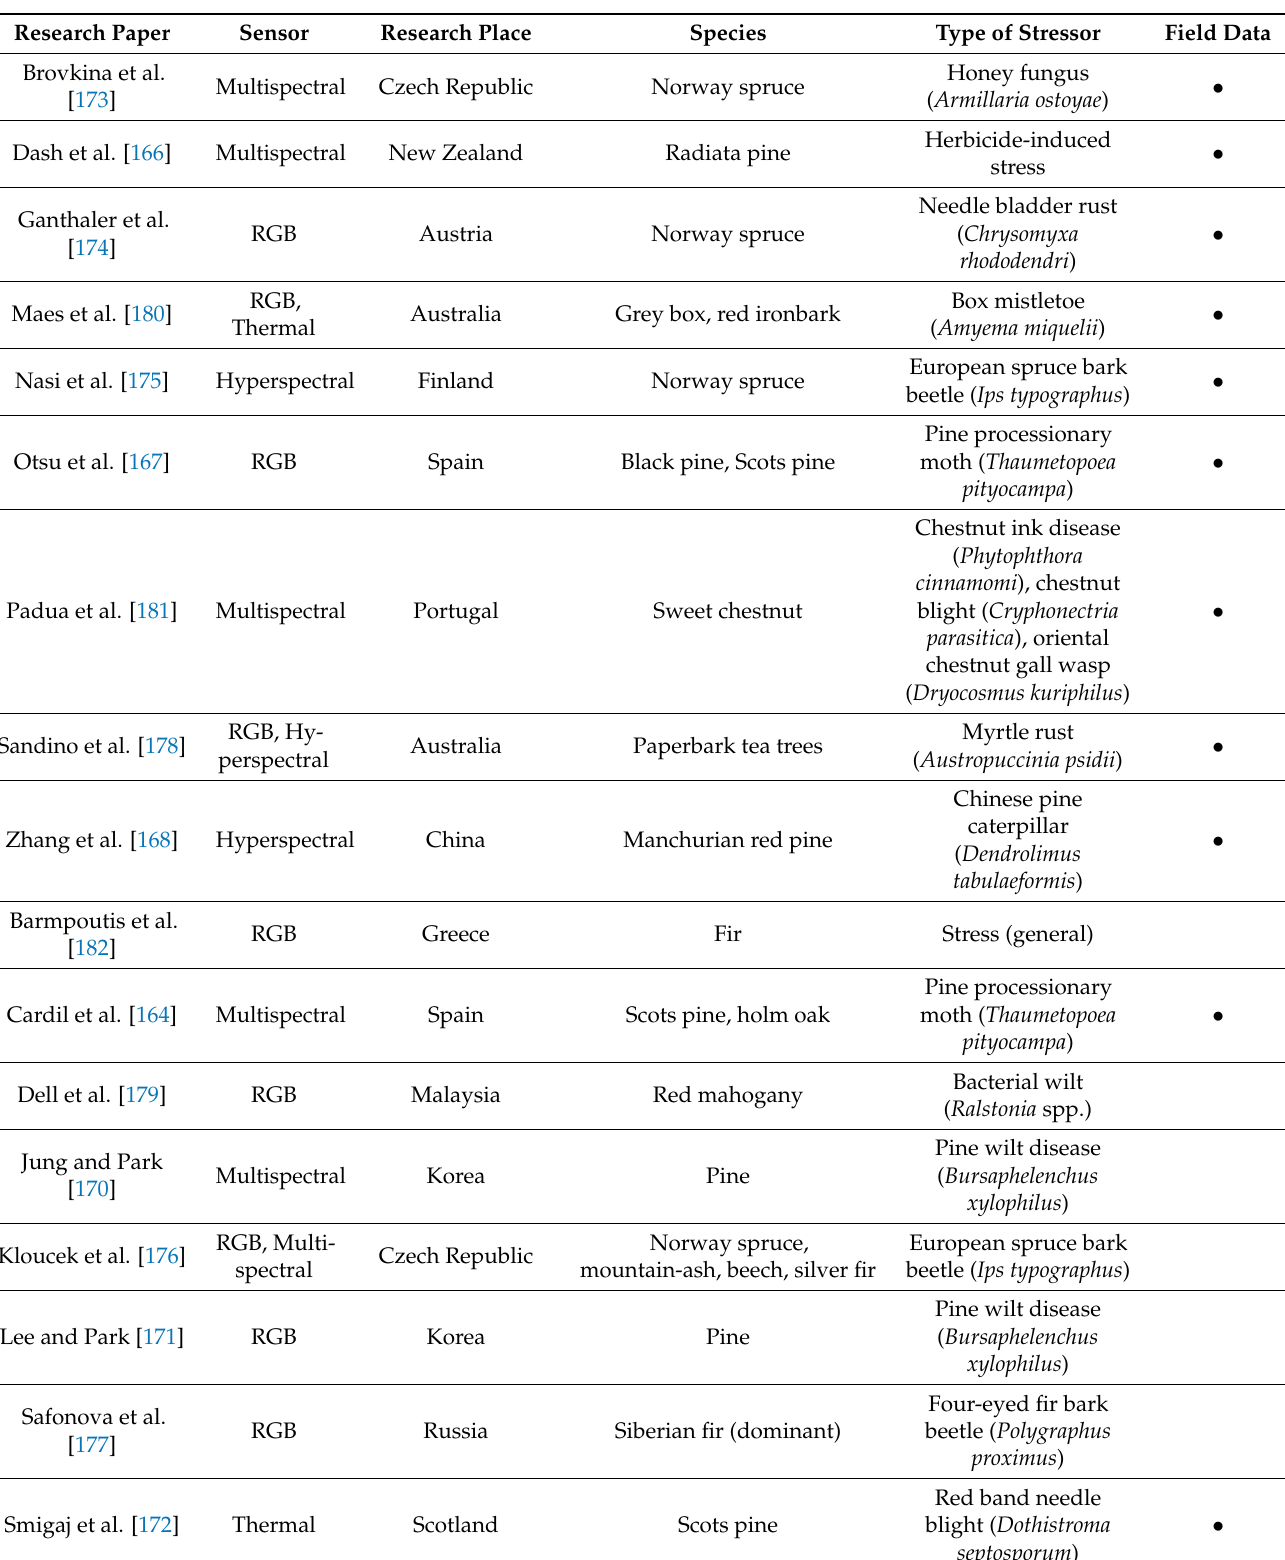
Table 4. Reviewed studies for pest and disease detection topic: sensor, research place, tree species, type of pest/disease/stress, and field data